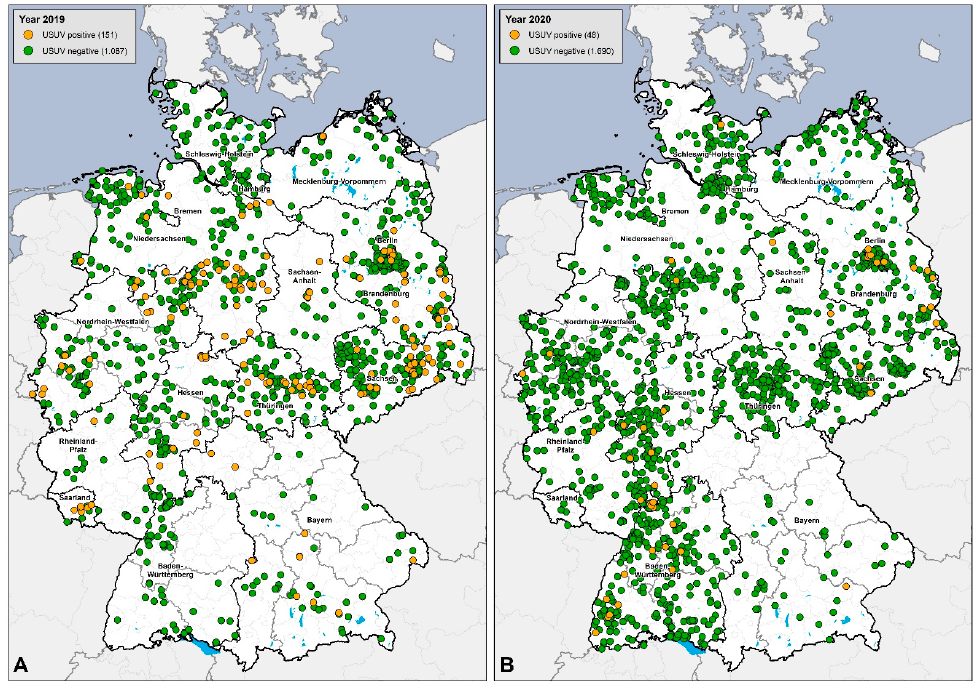
Figure 6. Database for USUV RNA detection in birds in Germany from 2019 and 2020. ( A ) Results from 2019: USUV-RNA-positive birds = 151 (orange dots) and USUV-RNA-negative birds = 1087 (green dots). ( B ) Results from 2020: USUV-RNA-positive birds = 48 (orange dots) and USUV-RNA- negative birds = 1690 (green dots).